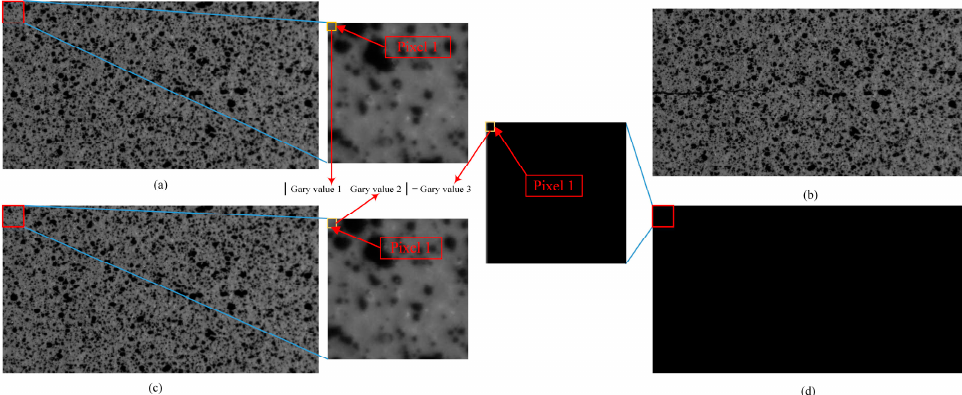
Figure 17. ( a ) Original reference image: ( b ) The captured target image; ( c ) the reference image of template matching; ( d ) the pixel gray value subtraction results of ( a ) and ( c ).